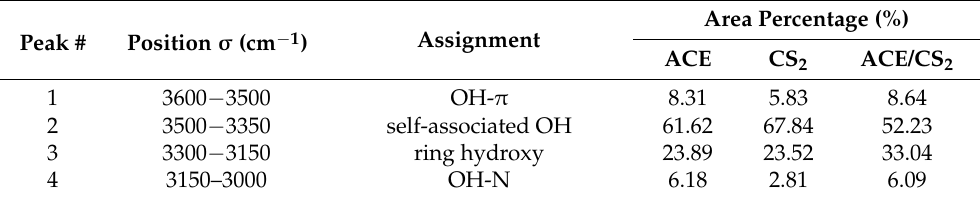
Figure 5. Infrared spectra of 3000–3600 cm − 1 extracts. (( a ) is the carbon disulphide fit, ( b ) is the acetone fit and ( c ) is the mixed solvent fit. The red line is the fitted curve and the blue line is the sub peak). Table 5. Infrared spectra of the three extracts 3000–3600 cm − 1 split peak fitting ratio of each absorption peak area [15].